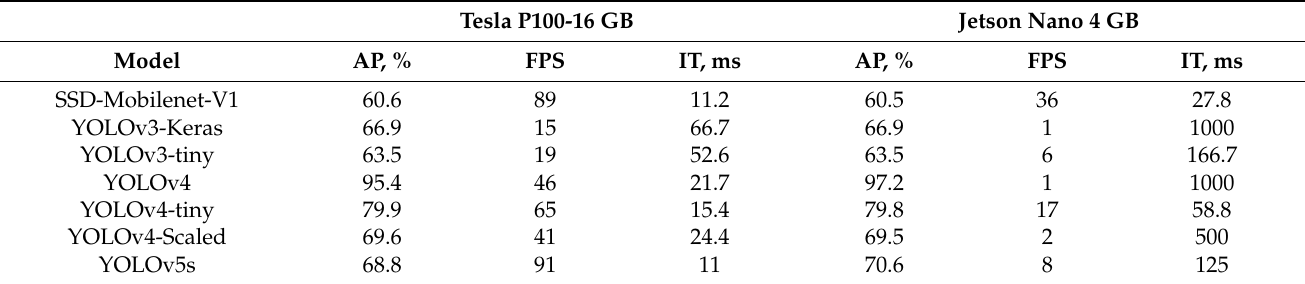
Table 5. Experimental results of investigated deep learning algorithm implementations for transistor detection.